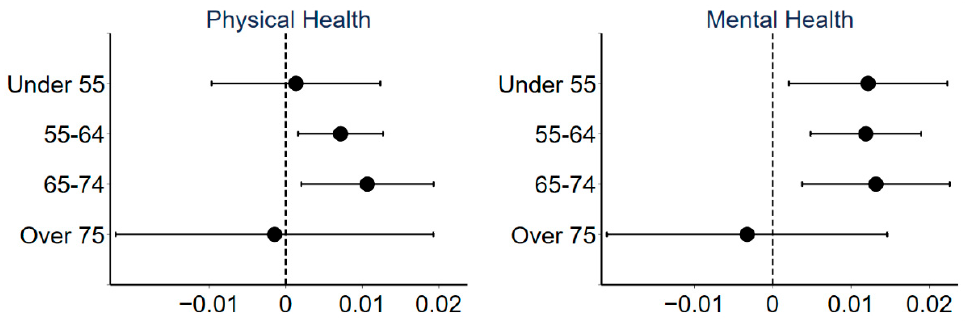
Figure 4. Coefficients and 90% confidence intervals of regressions for different age groups.